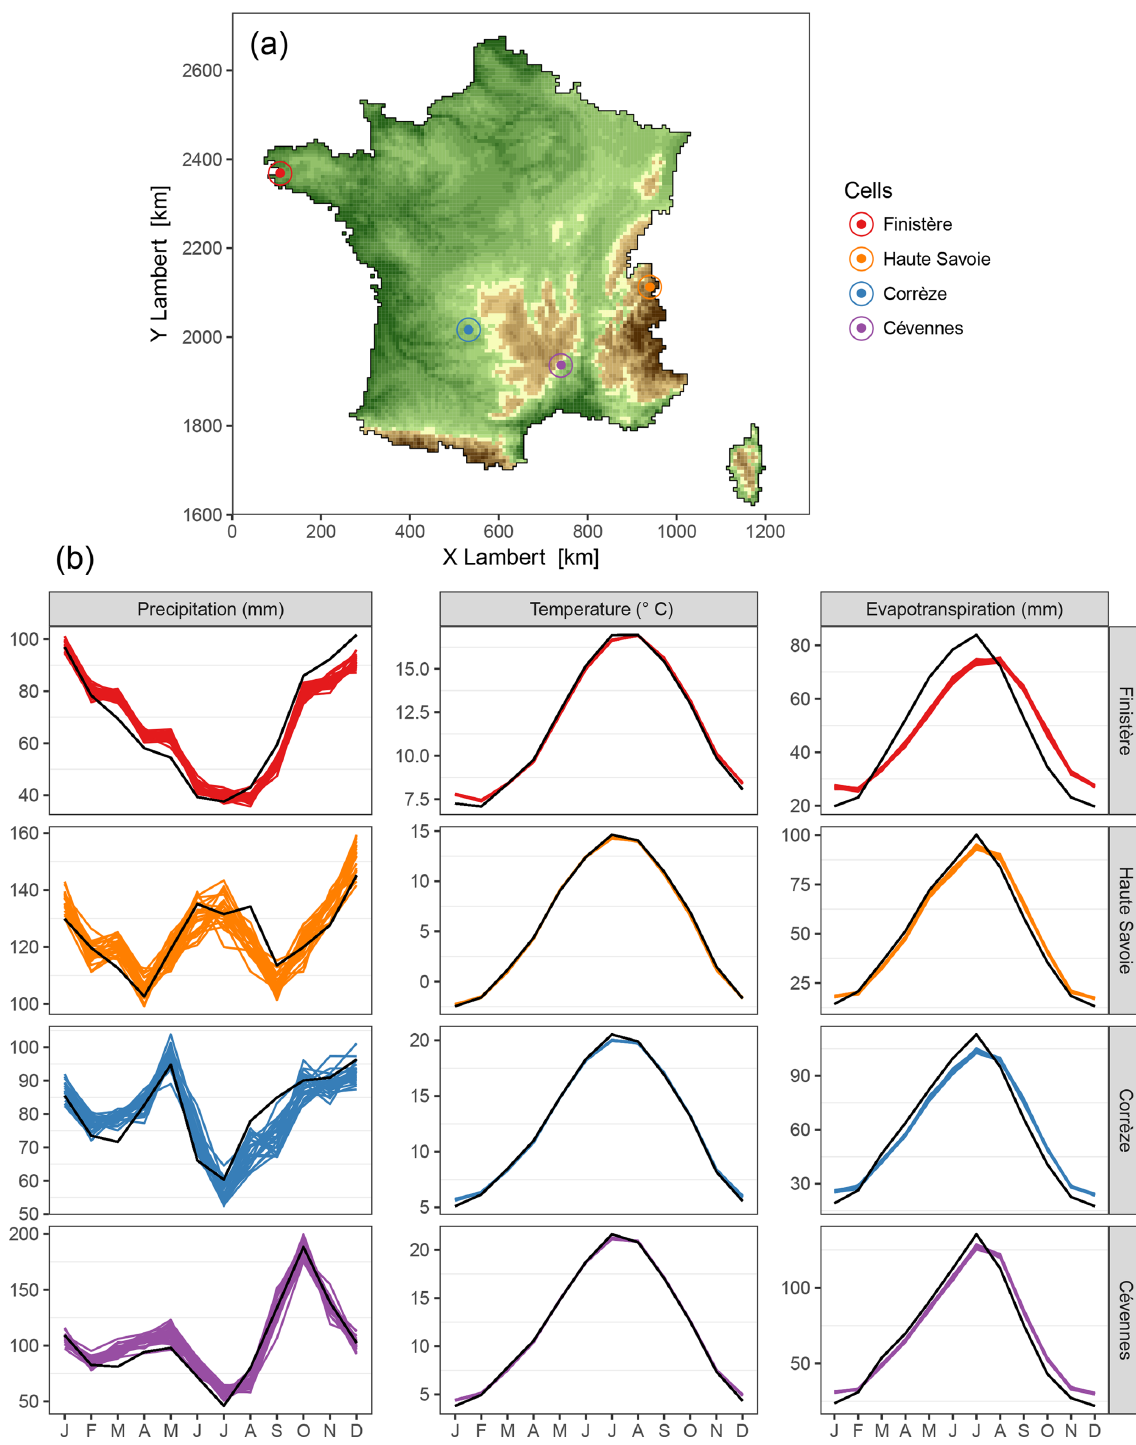
Figure 7. (a) Topographical map of France with location of the 4 case study cells: Finistère in Brittany, Haute-Savoie in the French Alps, Corrèze in the south-west, and Cévennes in the Massif Central mountain range. Brown corresponds to altitudes above 650m (up to 2933m). Green corresponds to altitudes under 500m. (b) Precipitation, temperature, and reference evapotranspiration interannual regimes between 1959 and 2007 from Safran (black) and SCOPE Climate (colours), through the 25 individual members, for the case study cells.